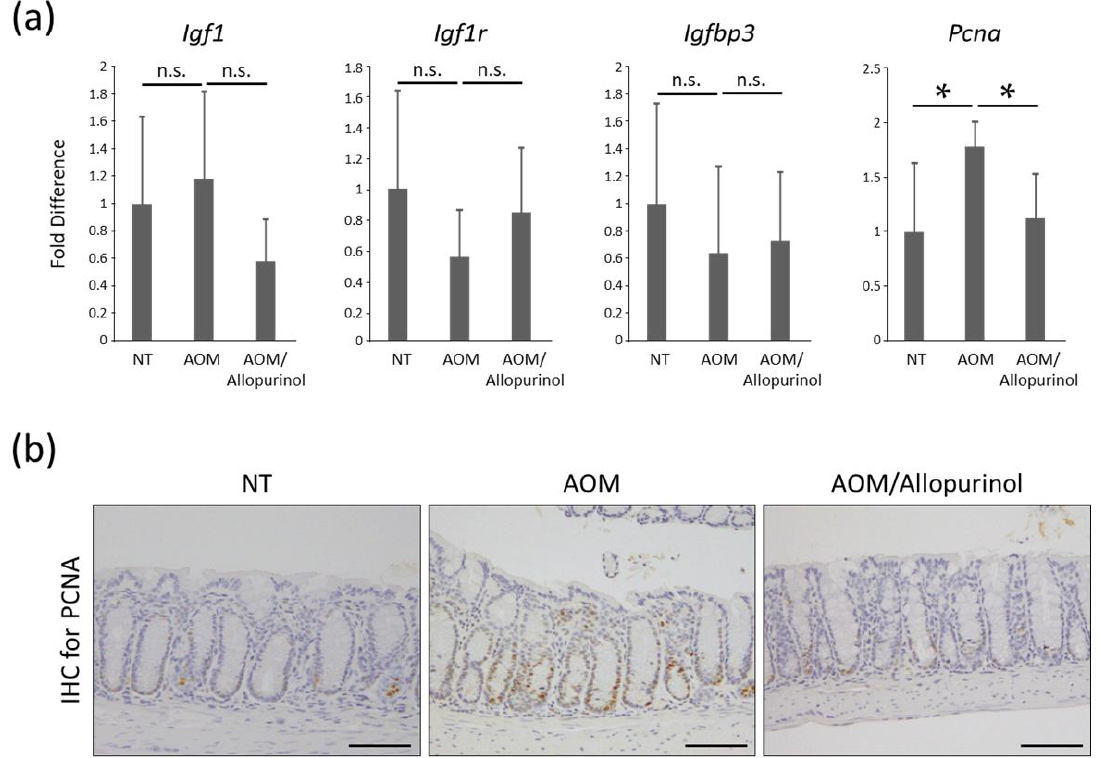
Figure 2. Effects of allopurinol on the IGF/IGF1R axis and cellular proliferation in the colonic mucosa of the experimental mice. ( a ) The mRNA expression levels of Igf1 , Igf1r , Igfbp3 , and Pcna in the colonic mucosa were analyzed by quantitative real-time RT-PCR with specific primers. Each column represents the mean ± SD. Asterisk (*) indicates the statistically significant difference between the groups; p < 0.05. ( b ) Evaluation of cellular proliferation in colonic mucosa of the experimental mice using an antibody for proliferating cell nuclear antigen (PCNA). Representative images are shown. Scale bars, 100 µm. AOM, azoxymethane; n.s., not significant; IHC, immunohistochemistry. NT, no treatment.